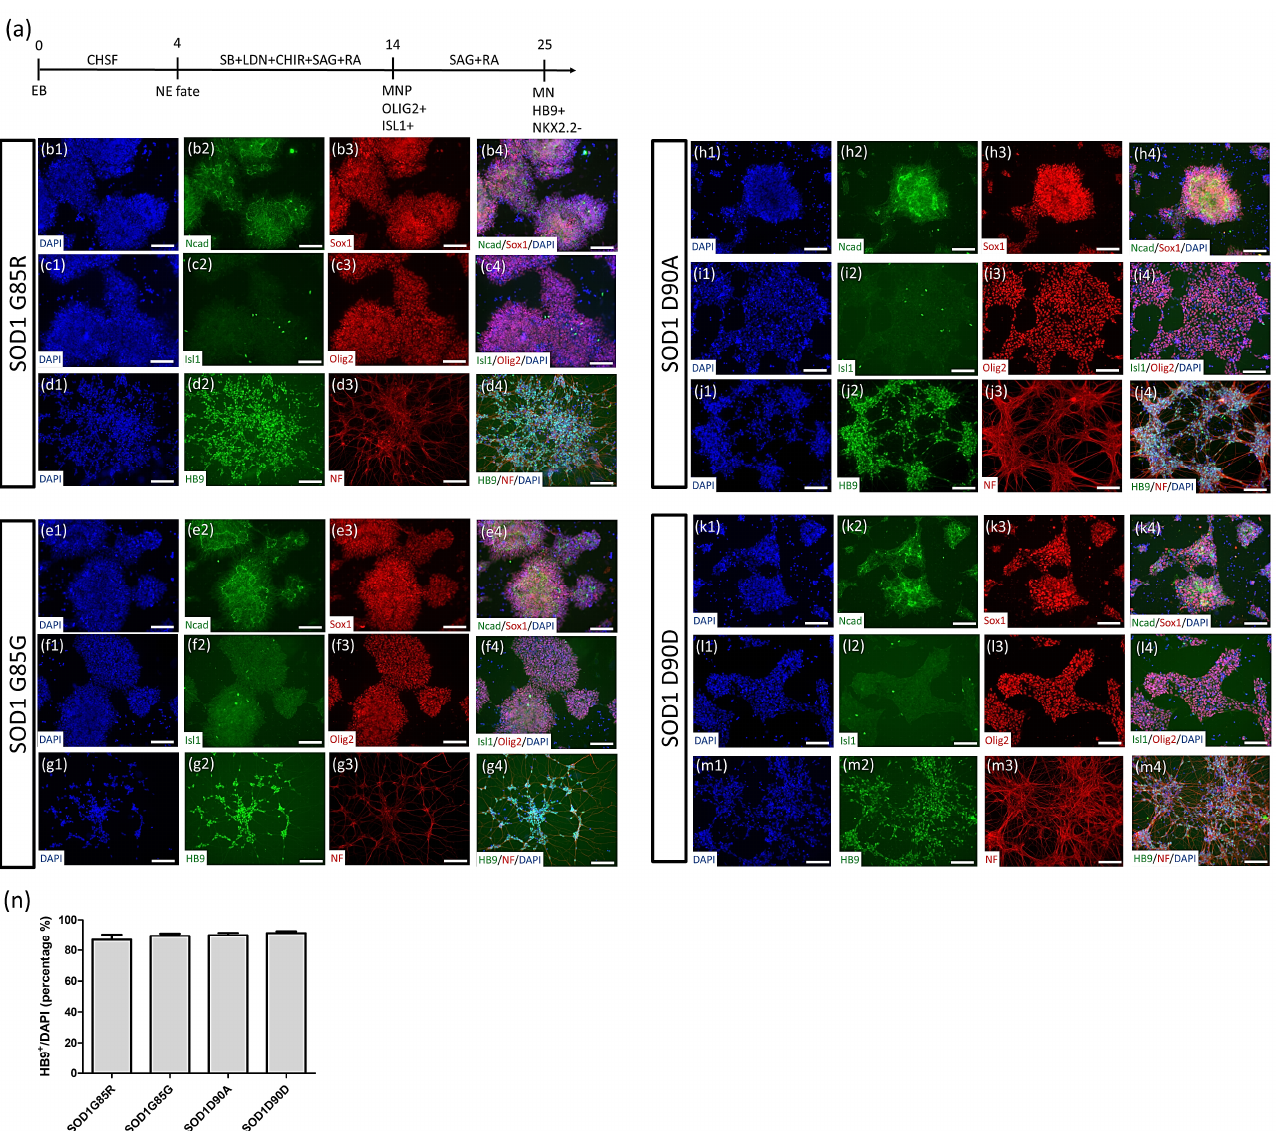
Figure 2. Robust generation of MNs from iPSCs. ( a ) Procedure for CHSF-based MN differentiation. ( b – m ) Identification of SOD1 G85R ( b – d ), SOD1 G85G ( e – g ), SOD1 D90A ( h – j ), and SOD1 D90D ( k – m ) iPSC line-derived MN progenitors and MNs. Every line was identified with neural stem cell markers (N-cadherin and Sox-1) and MN progenitor markers (Oligo-2 and Islet-1) at day 15 of differentiation, and with an MN marker (HB9) and a neuronal marker (NF) at days 23–25 of differentiation. ( n ) Calculation of the HB9 expression ratio of DAPI + cells. Scale bar, 100 µ